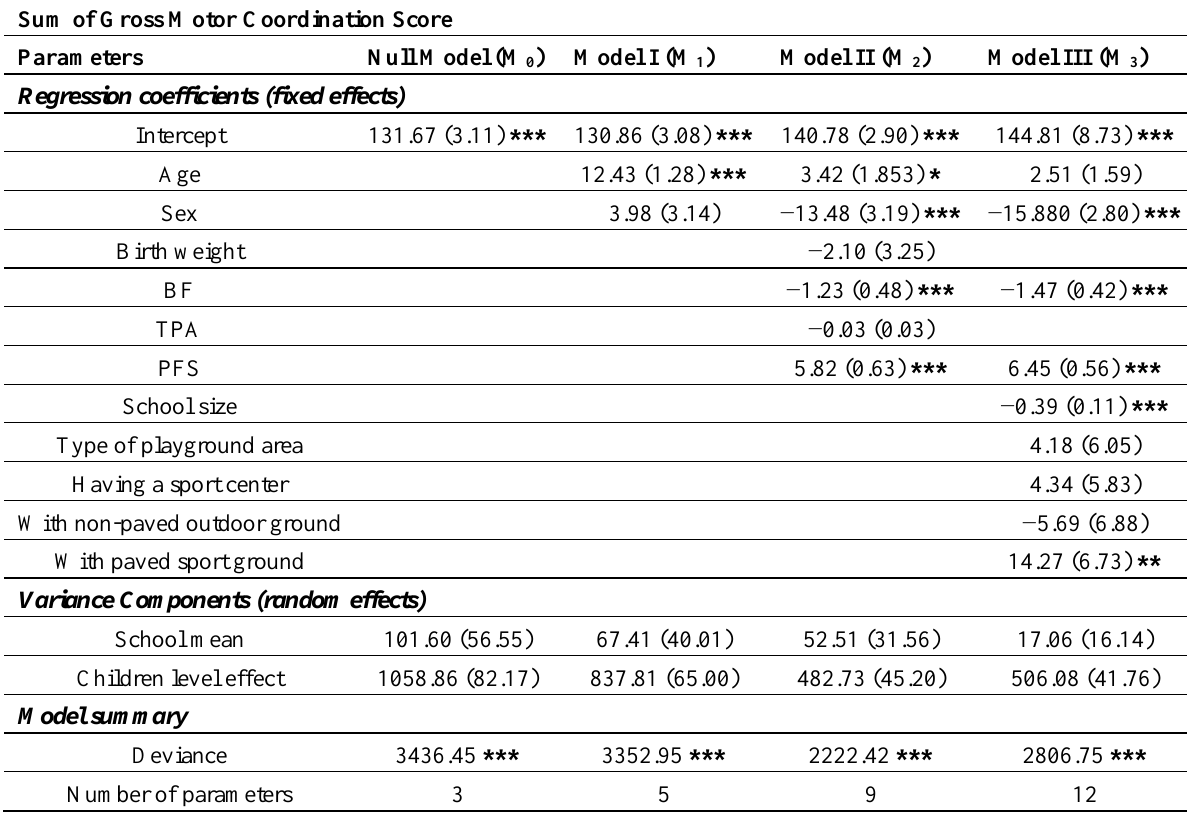
Table 3. Summary of results of the three nested